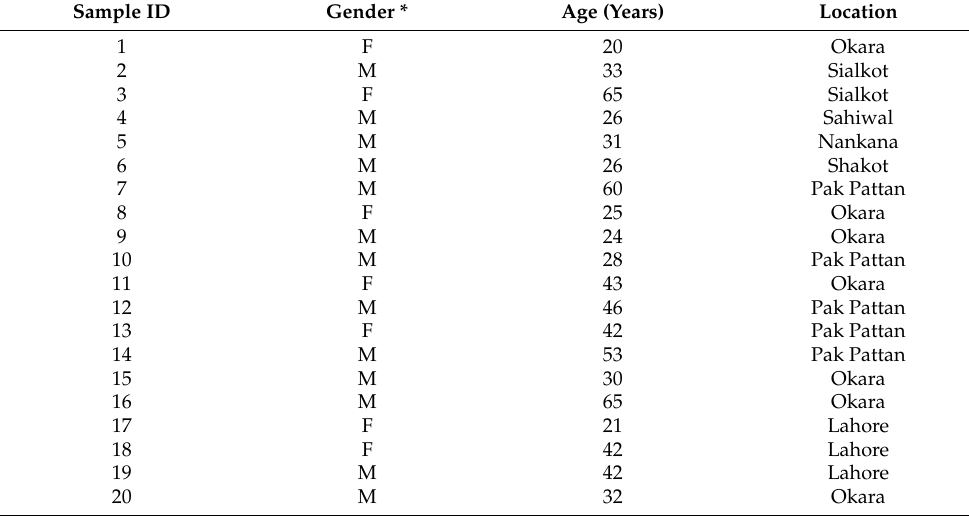
Table 1. SARS-CoV-2 patients’